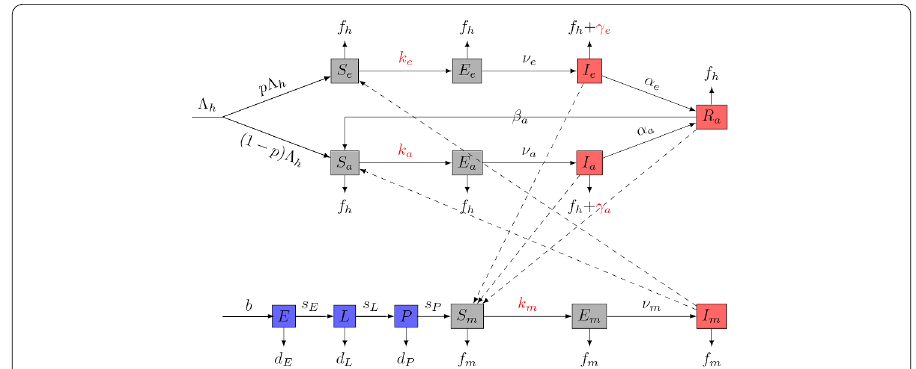
Figure 2 A schematic of the mathematical model for malaria transmission involving the human host susceptibility, exposedness and infectivity with variable non-immune, semi-immune and mosquitoes population. The dashed arrows indicate the direction of the infection and the solid arrows represent the transition from one class to another